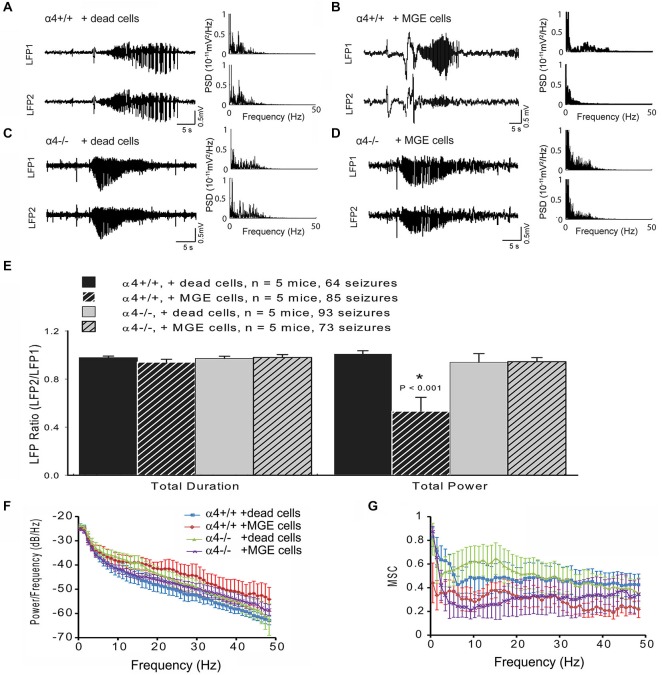
MGE-IP transplants fail to attenuate seizure propagation in GABAA-R α4−/− mice. (A–D) local field potential (LFP) recording (left panel) from an α4+/+ mouse under control conditions (A) and following MGE-transplantation (B). (C,D) 4-AP-induced seizure-like electrical activity recorded from α4−/− mice under control (C) and 30-days post-MGE transplant (D) conditions. Right panel (A–D) displays the power spectral density (PSD) of the LFP recording. (E) Summary data for ictal duration and power for each condition by genotype. (F) Averaged cross spectral density estimate and (G) averaged magnitude-squared coherence (MSC) for each condition by genotype.